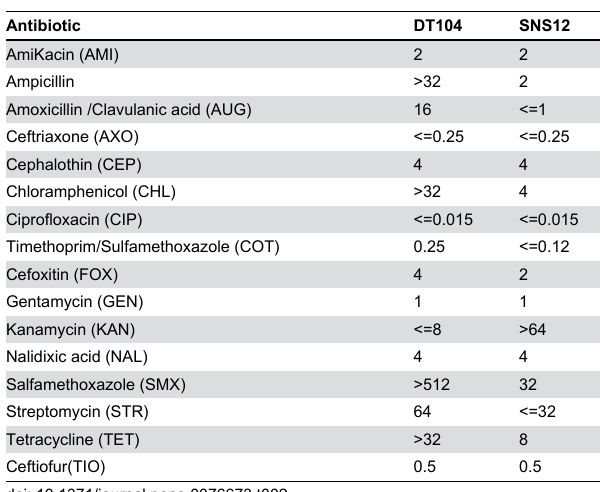
Table 2. Minimum Inhibitory Concentrations (MIC) of the several antibiotics against Salmonella enterica serotype Typhimurium phagetype DT104 and its isogenic ΔMDR mutant,